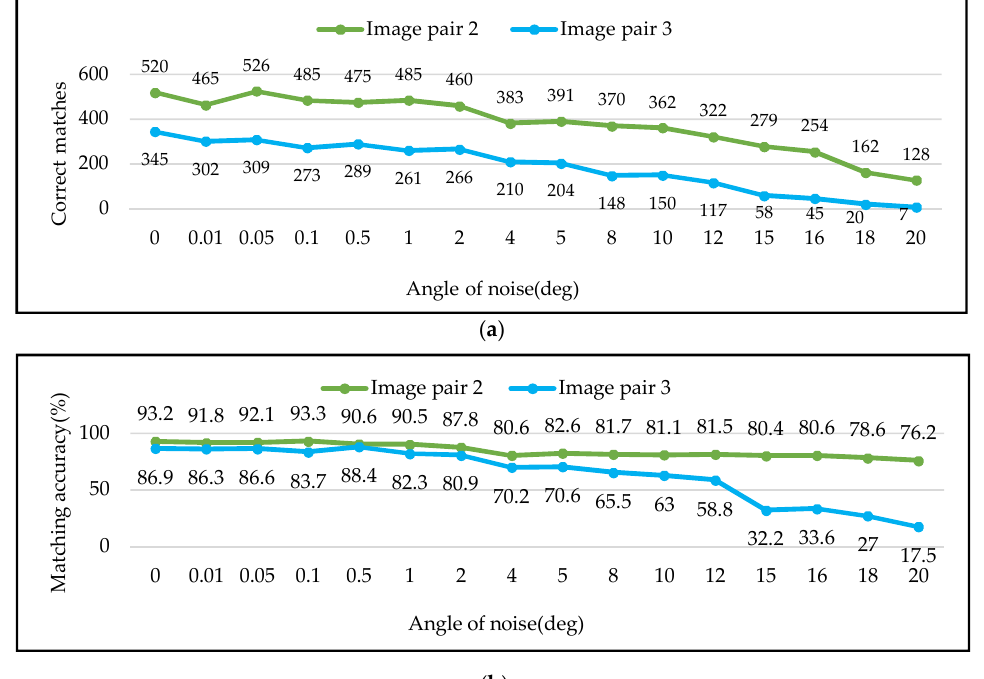
Figure 18. Matching outcomes with different angles of noise: ( a ) The number of correct matches; ( b ) Matching accuracy.